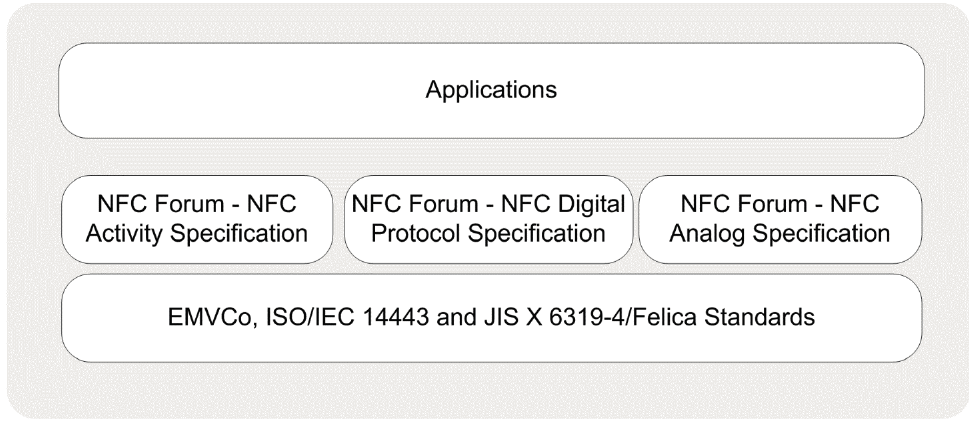
Figure 5. Protocol stack of card emulation operating